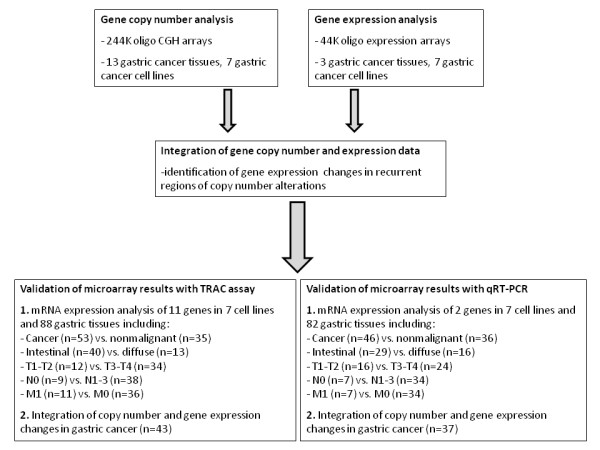
Flowchart describing different steps of the study.